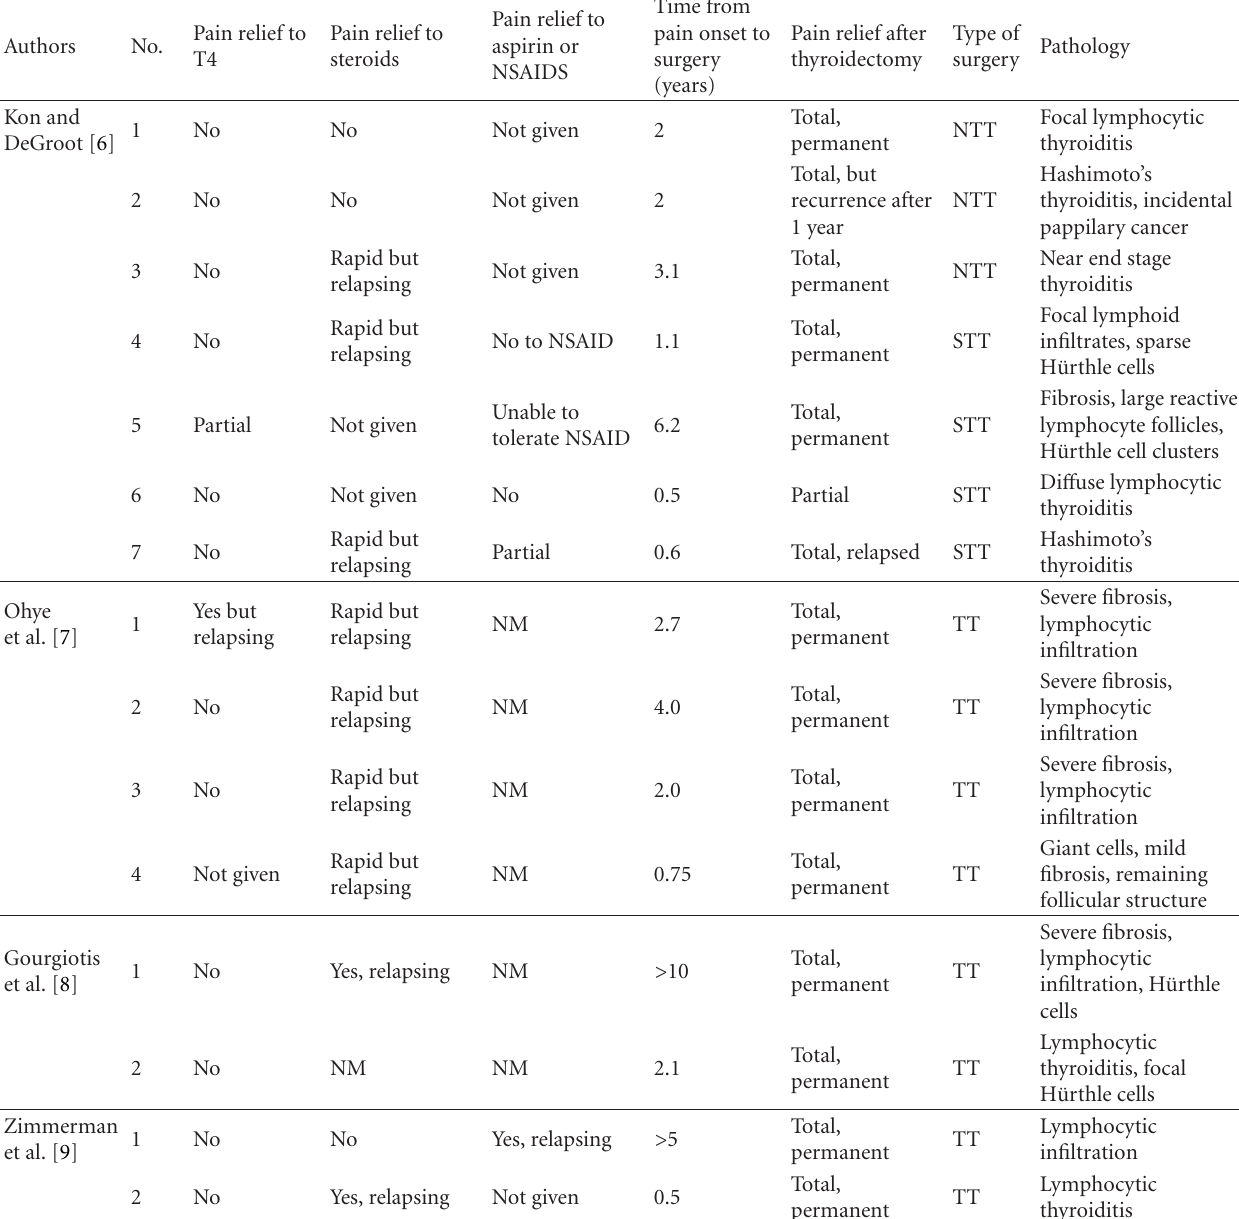
Table 2: Pain relief to treatment and surgical pathology in fifteen cases of painful Hashimoto’s